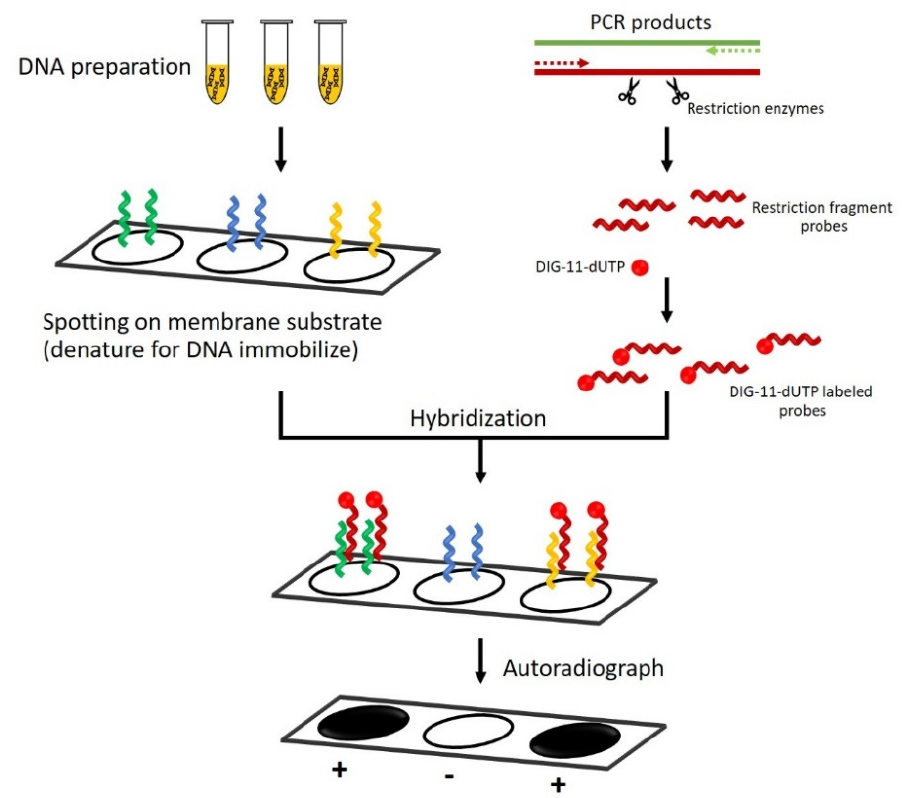
Figure 3. Diagram of the dot-blot hybridization technique for detecting a target nucleic acid sequence of P. insidiosum . Different DNA samples (represented by green, blue, and yellow curly lines) are extracted from the organism and blotted onto a membrane (the left arm of the diagram). A DNA probe (represented by a red curly line) is prepared by using a restriction enzyme and labeled with a chemiluminescent molecule (i.e., digoxigenin (DIG)-11-dUTP; represented by a red dot) to generate a detection signal (the right arm of the diagram). The blotted target DNAs are denatured into single strands by heat or alkali treatment before hybridizing them with the DIG-11-dUTP-labelled probe. After removing unbound radioactive probes through a washing step, the hybridized membrane is subjected to X-ray film exposure. Only a sample containing a DNA complementary sequence with the labeled probe shows a black spot on the film, indicating a positive result.